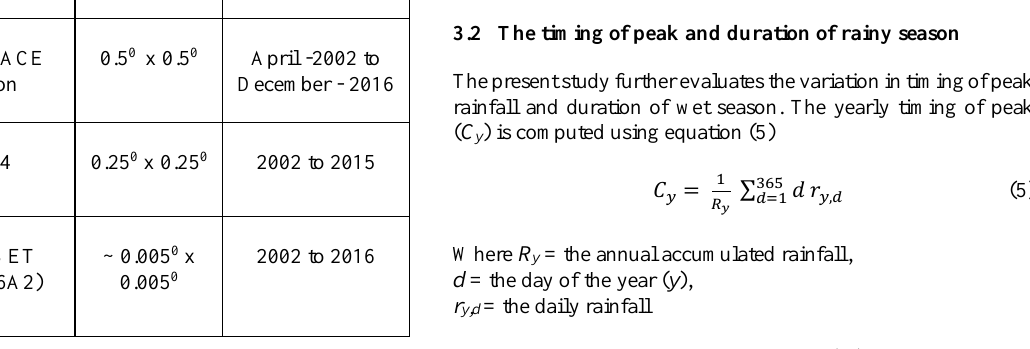
Table 1. Summary of datasets used in the present study